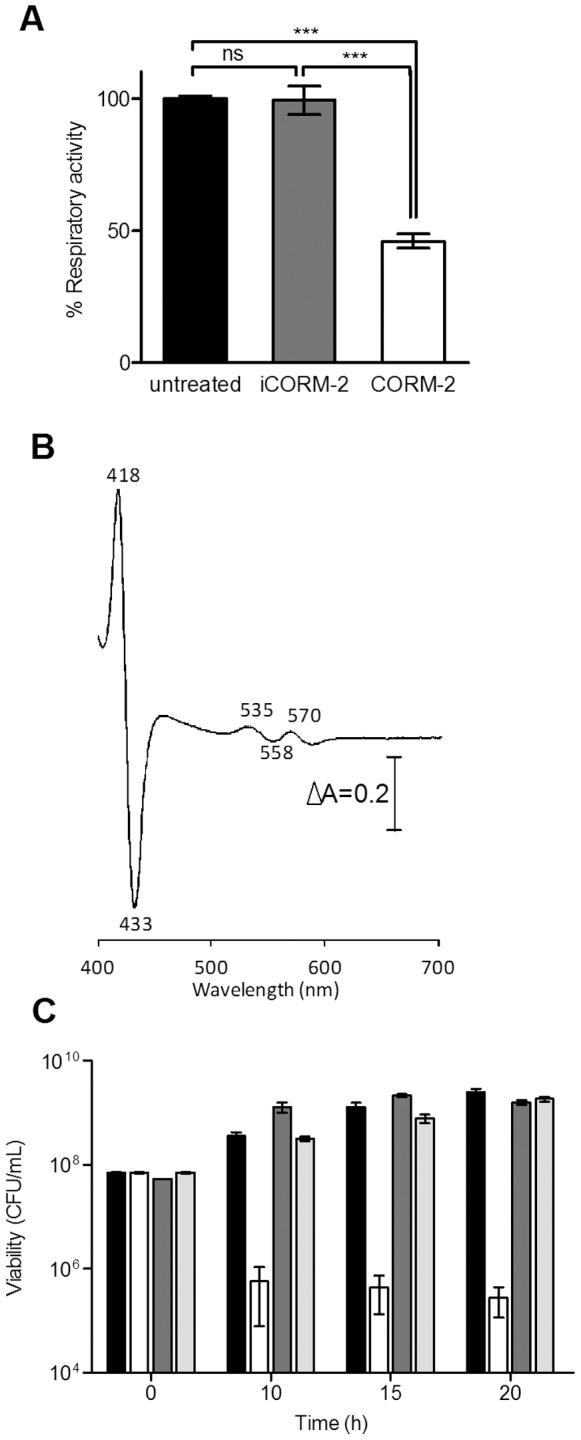
CORM-2 inhibits H. pylori respiration.(A) Cellular suspensions of H. pylori were left untreated (black) and treated for 5 min with 50 mg/L iCORM-2 (grey) and 25 mg/L CORM-2 (white). Oxygen consumption was measured, after the addition of pyruvate (5 mM) in a Clark-type O2 electrode for two biological samples of H. pylori assayed in triplicate. Values are expressed as means ± SE. ***p<0.001, ns - non significant (One-way ANOVA and Bonferroni test). (B) Spectral characterization of H. pylori cells treated with CORM-2. CORM-2 (200 mg/L) was added to reduce cells of H. pylori and the spectra recorded 5 min after addition of compound. Numbers indicate wavelength features (nm) in the difference reduced-plus-CORM-2 minus reduced spectrum. Two independent biological samples were analyzed. (C) Viability of H. pylori grown in BHI-βCD medium (black) and exposed to 200 mg/L CORM-2 alone (white), and in the presence of 5 mM glutathione (dark grey) or 5 mM cysteine (light grey). Values represent average of three biological samples with the respective SE.